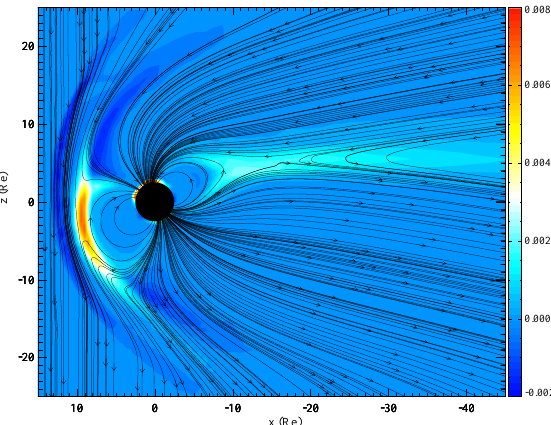
Plate 7. Traces of the magnetic field in the X − Z plane, ignoring B y , over J y in units of µA/m 2 . This figure illustrates a summer solstice condition in at 16:45 UT, in which the Northern Hemisphere magnetic pole is pointed further towards the Sun. The density of the fields lines does not correspond to the strength of the